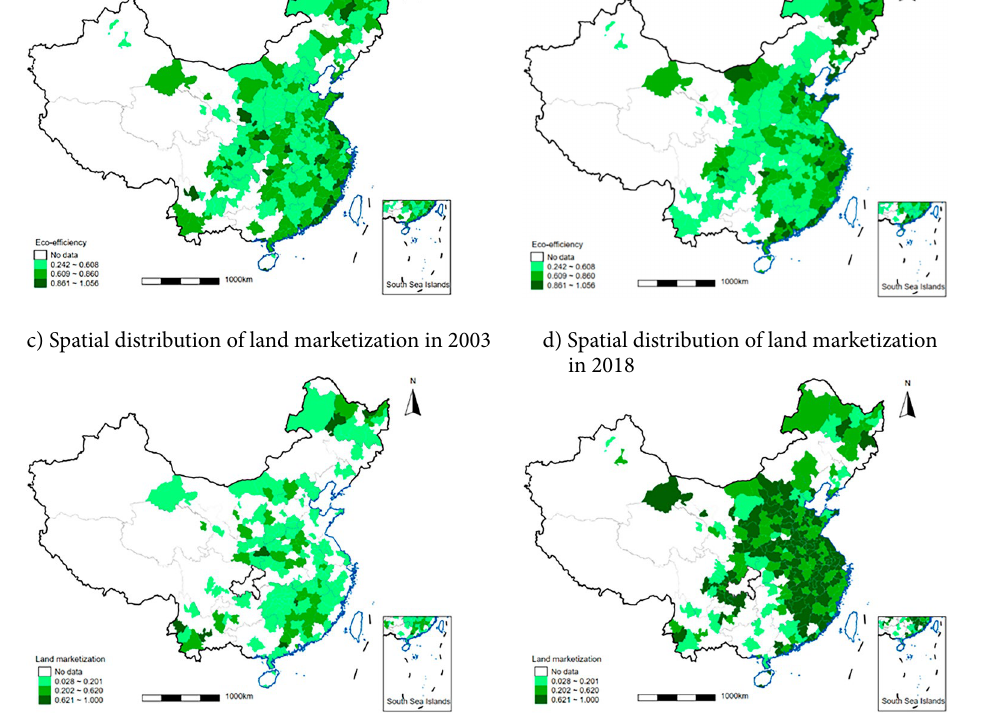
Figure 2. The spatial distribution of eco-efficiency and land marketization in China for 2003